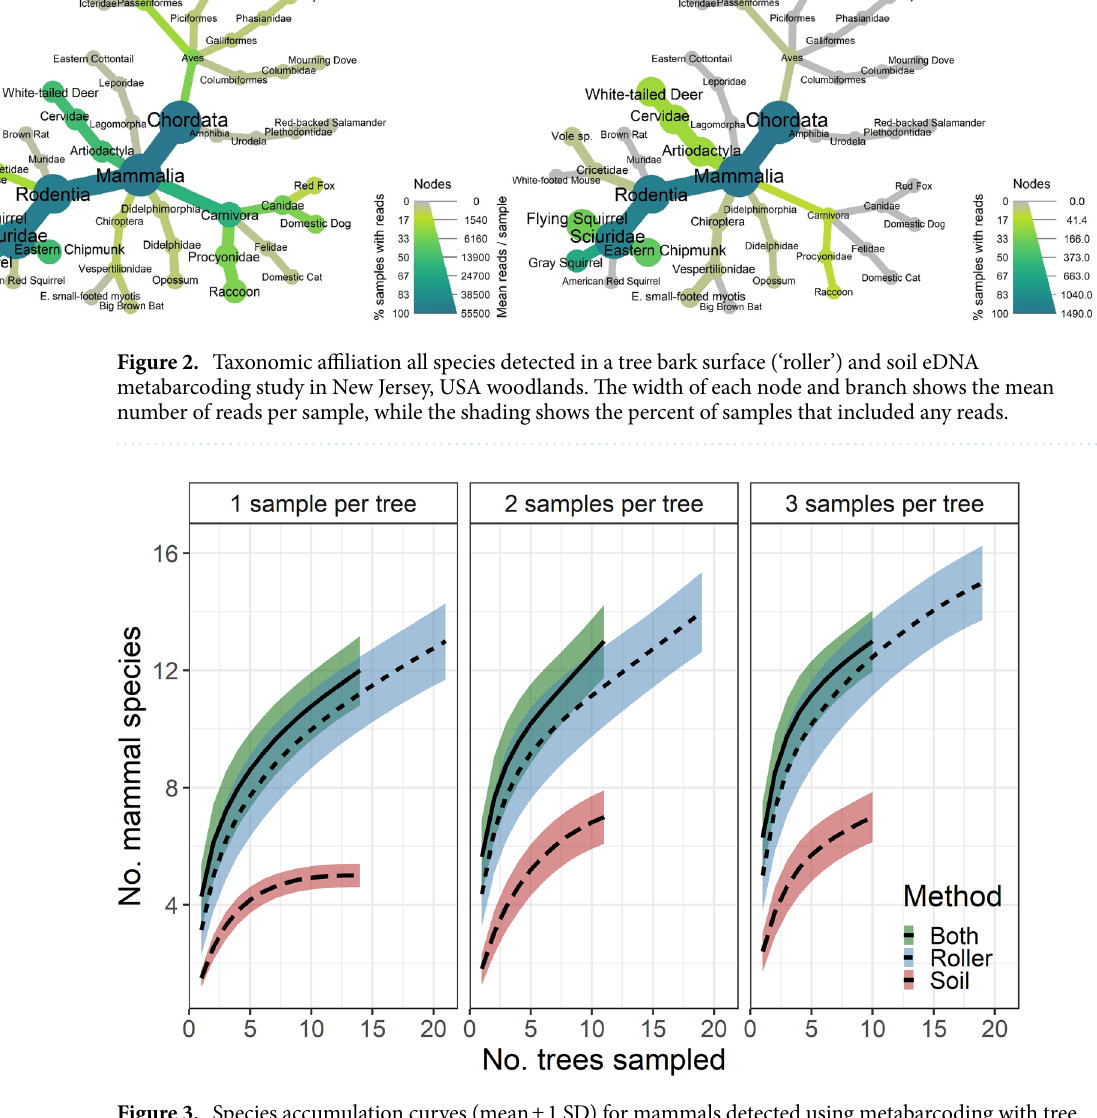
Figure 3. Species accumulation curves (mean ± 1 SD) for mammals detected using metabarcoding with tree bark surface (‘roller’) or soil eDNA sampling and varying numbers of sampling visits per tree (1–3). ‘Both’ refers to the pooled results at trees where both roller and soil sampling was